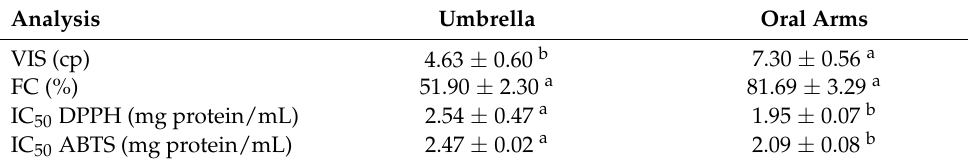
Figure 3. 1 H-NMR spectra of jellyfish umbrella ( A ) and oral arm ( B ) gelatins. Amino acids are indicated by their corresponding peaks: Lysine (Lys), threonine (Thr), isoleucine (Ile), glutamate (Glu), proline (Pro), histidine (His) and imino amino acid group of hydroxymerodesmosine (HMD). Table 5. Viscosity (VIS), foaming capacity (FC), and antioxidant activity as measured in terms of DPPH and ABTS-radical scavenging activity, of umbrella and oral arms gelatins from dry-salted brown cannonball jellyfish 1